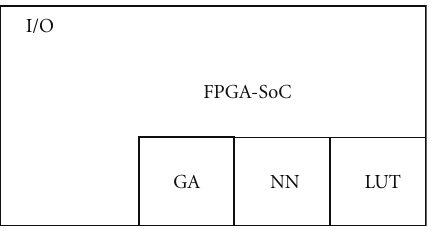
Figure 3: A vision of an FPGA chip with its input/output (I/O) circuitry and possibly loaded with a few recovery engines such as GA, NN, and an